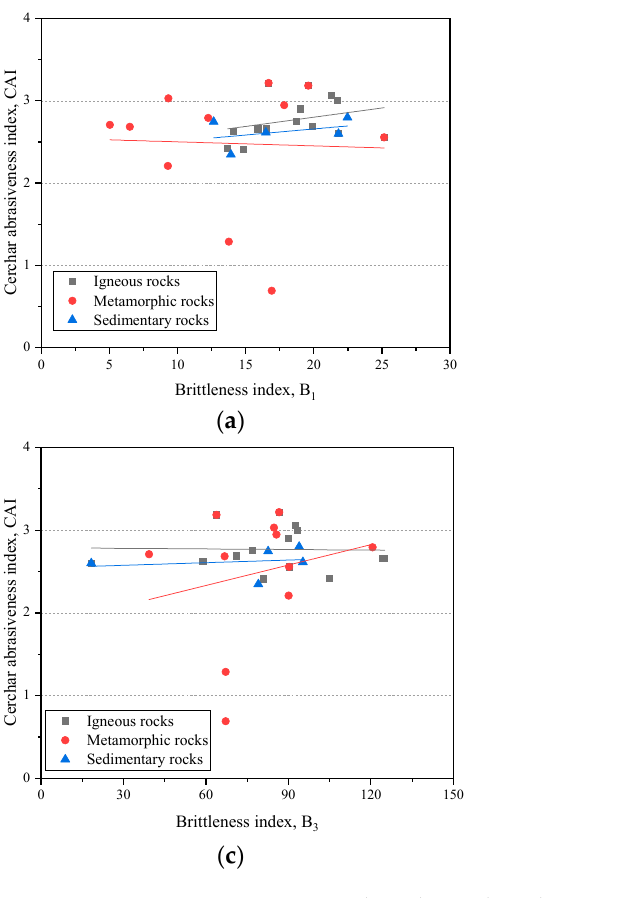
Figure 11. The relationships between the Cerchar abrasiveness index and brittleness indices: ( a )